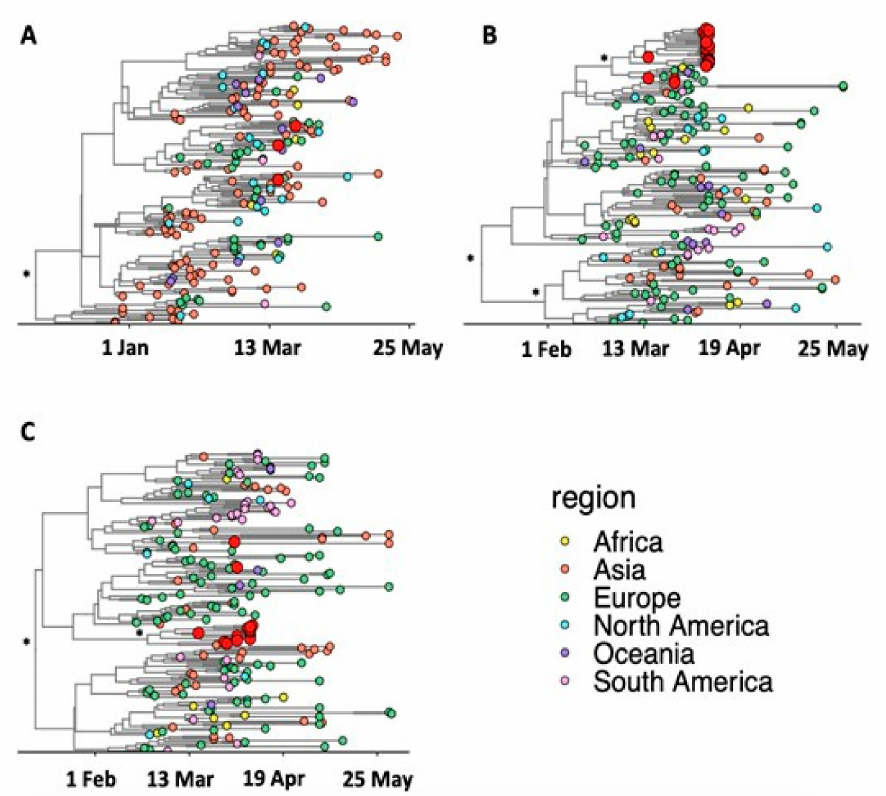
Figure 4. Bayesian Maximum Clade Credibility trees of major SARS-CoV-2 clades. ( A ) Clade 19A, ( B ) Clade 20 A and ( C ) Clade 20B. The sequences are colored according to their region of sampling, while Cape Town sequences are labelled in red. The branches of the tree topology are in calendar time while well-supported splits in the tree topology (posterior support > 0.9) are marked with an asterisk